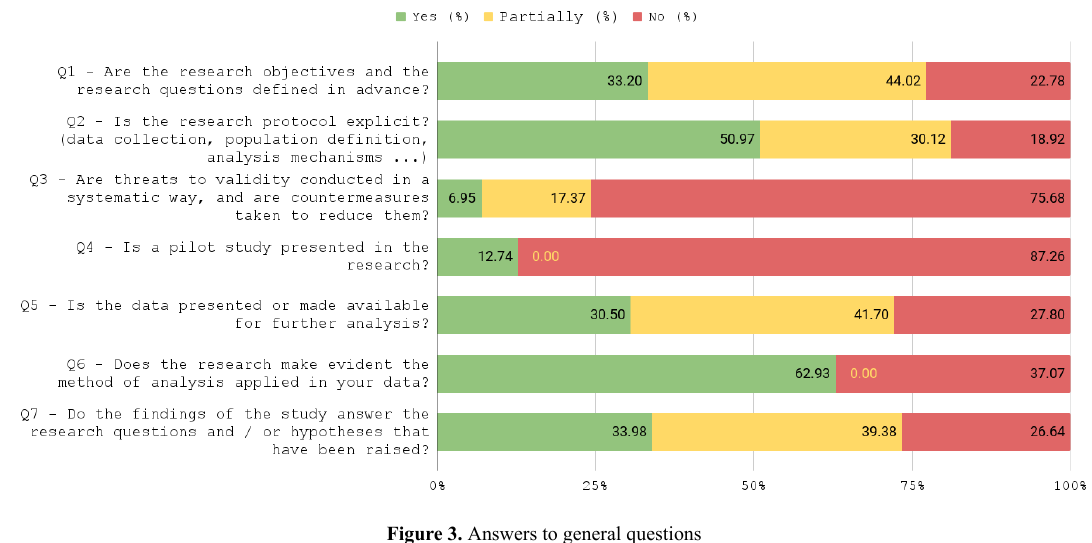
Figure 3. Answers to general questions